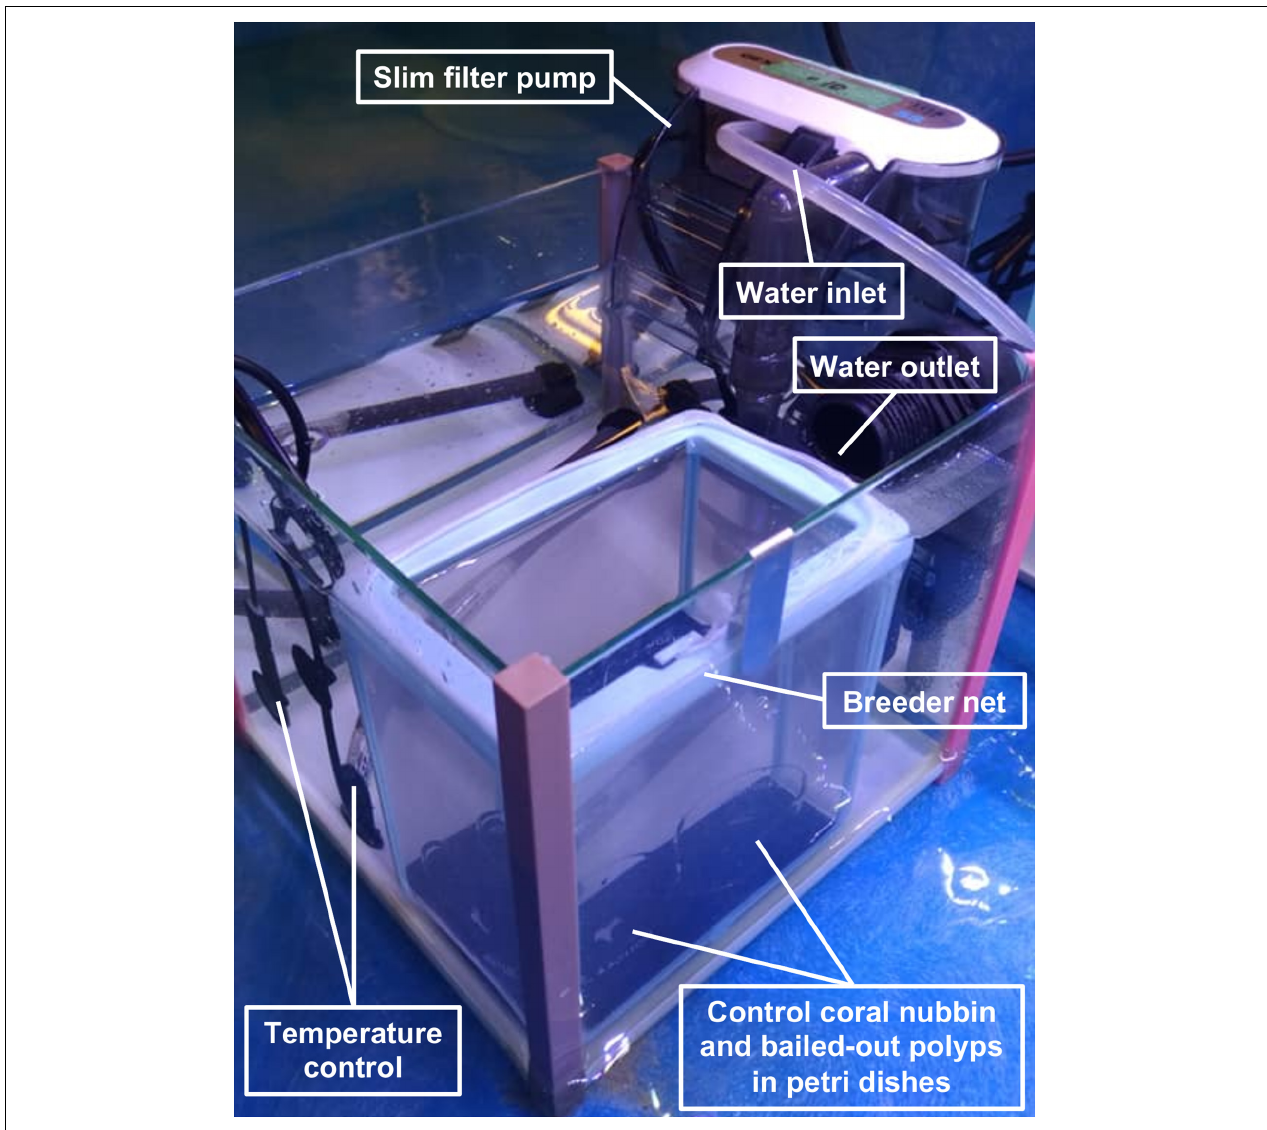
FIGURE 1 | Experimental setup for polyp recovery after bail-out.